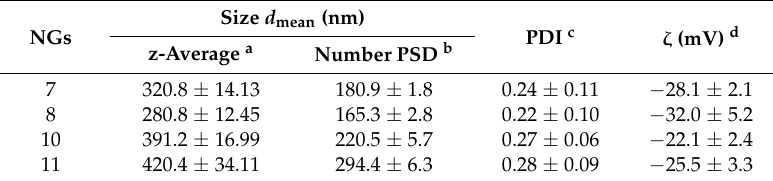
Figure 8. ( A ) Size distribution by intensity: TSPO-Dex NGs 7 (a); TSPO-Dex NGs 8 (b); TSPO-Dex NGs 10 (c) and TSPO-Dex NGs 11 (d). ( B ) Size distribution by number: TSPO-Dex NGs 7 (a); TSPO-Dex NGs 8 (b); TSPO-Dex NGs 10 (c) and TSPO-Dex NGs 11 (d). ( C ) Zeta Potential Distribution: TSPO-Dex NGs 7 (a); TSPO-Dex NGs 8 (b); TSPO-Dex NGs 10 (c) and TSPO-Dex NGs 11 (d). Table 3. Physicochemical characteristics of TSPO-Dex NGs.